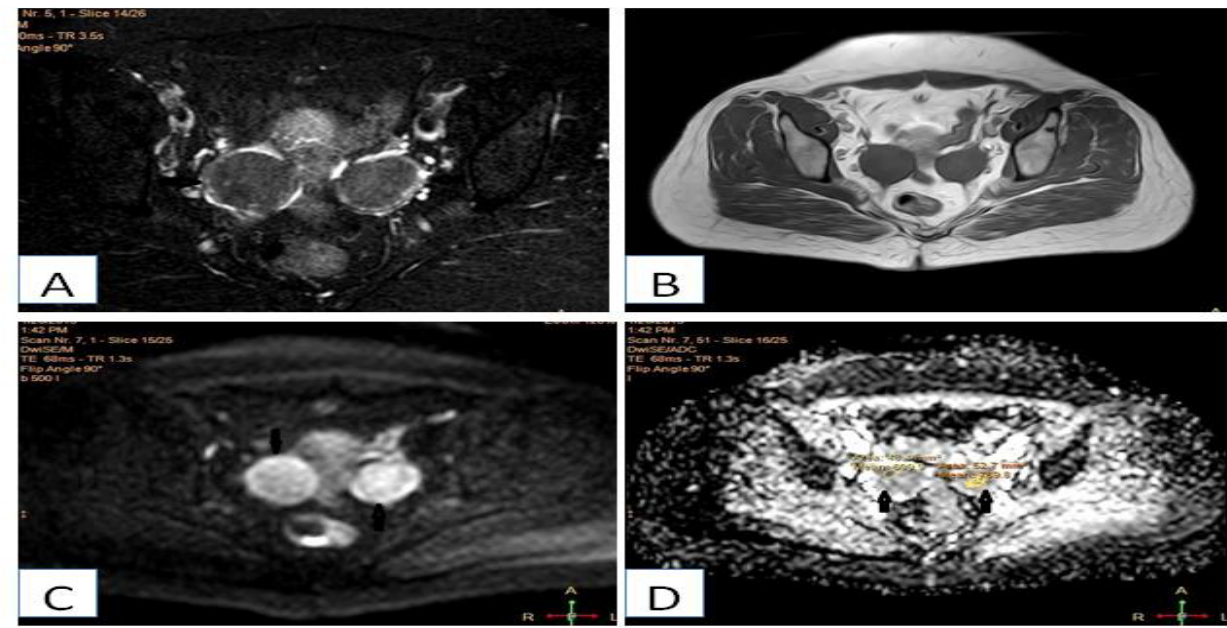
Figure (2): 33 years old female with bilateral ovarian fibromas (a) coronal T2 wiegthed image. (b) Axial T1 post contrast – weighted image post contrast. (c) Axial DWI on b value 1000 mm 2 /s shows hyper intensity (d) axial ADC shows low signal intensity with mean ADC value 0.759 x10 -3